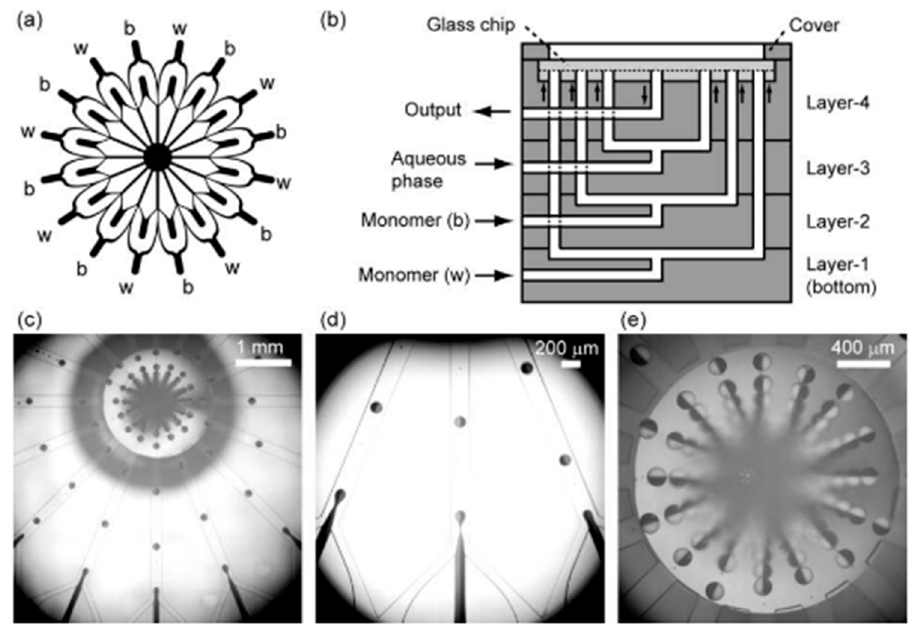
Figure 32. Production of Janus drops in the chip consisted of 16 Y-shaped inlet channels followed by 16 cross junctions: ( a ) Schematic of the channel geometry on the chip. The “b” and “w” labels specify the inlet positions for the black and white monomers respectively. The aqueous phase is injected from the inner 16 inlets, arranged radially with an outlet in the centre; ( b ) Schematic of the layered internal structure of the device (side view); ( c ) A micrograph showing the formation of black and white monomer drops in the module; ( d ) The magnified image of the drop makers; ( e ) Magnified image of the large outlet channel in the centre of the chip. Reproduced with permission from Nisisako et al. [152], published by American Institute of Physics, 2006.